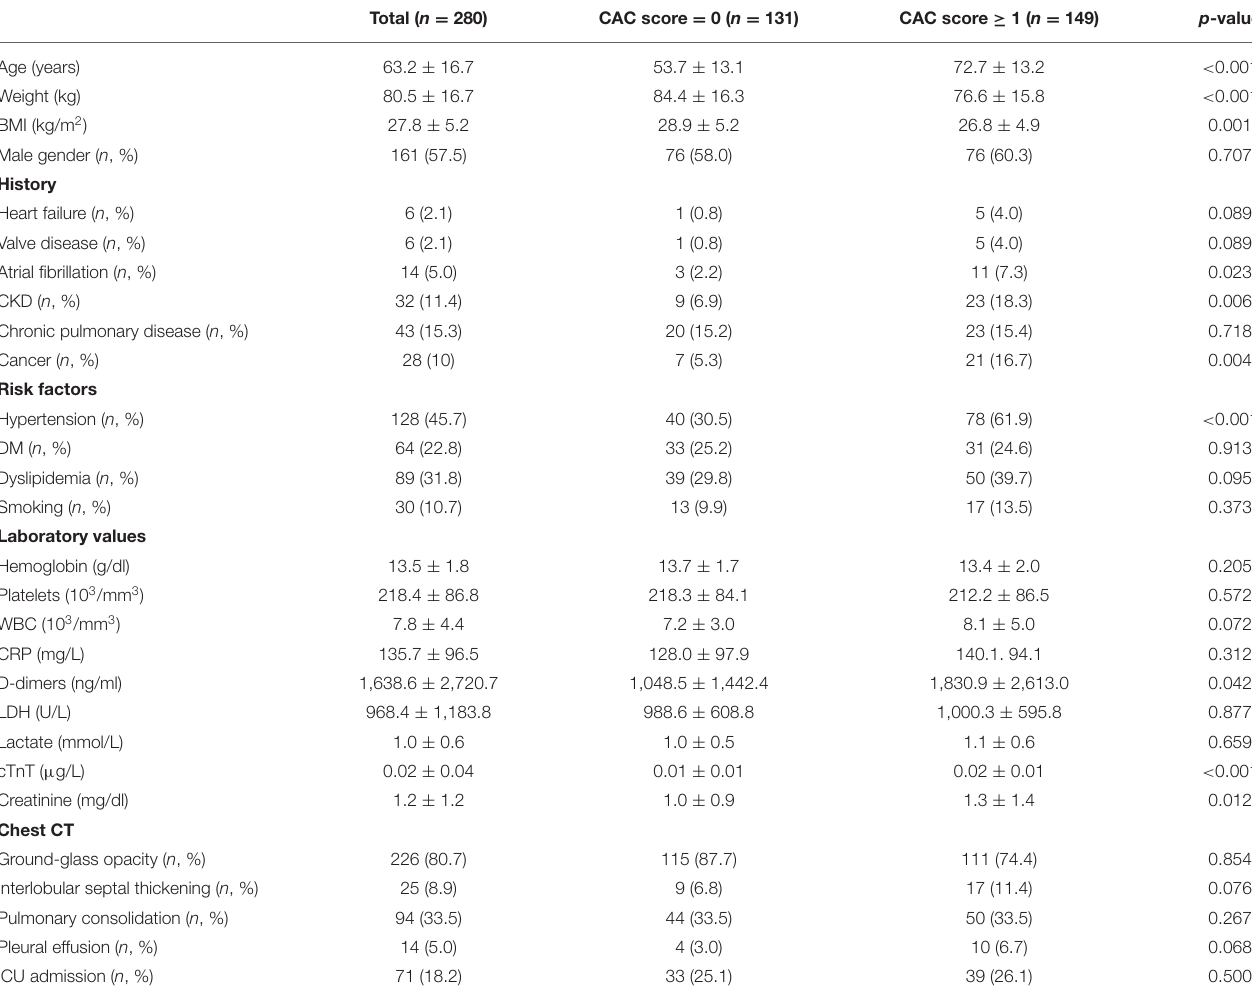
TABLE 1 | Comparison between patients with CAC score 0 and those with CAC score ≥